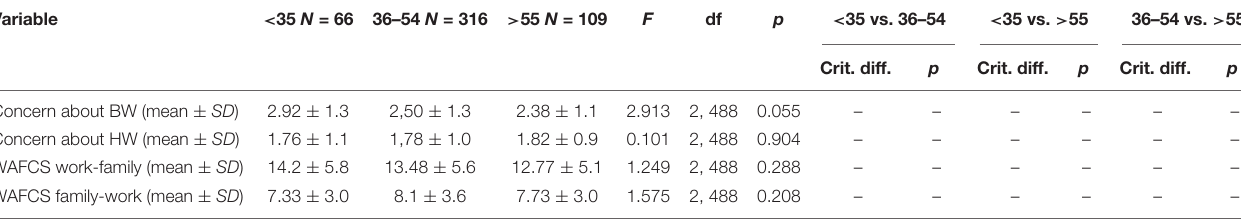
TABLE 6 | Questionnaires scores in the Vaccination Round group by age class. Variable